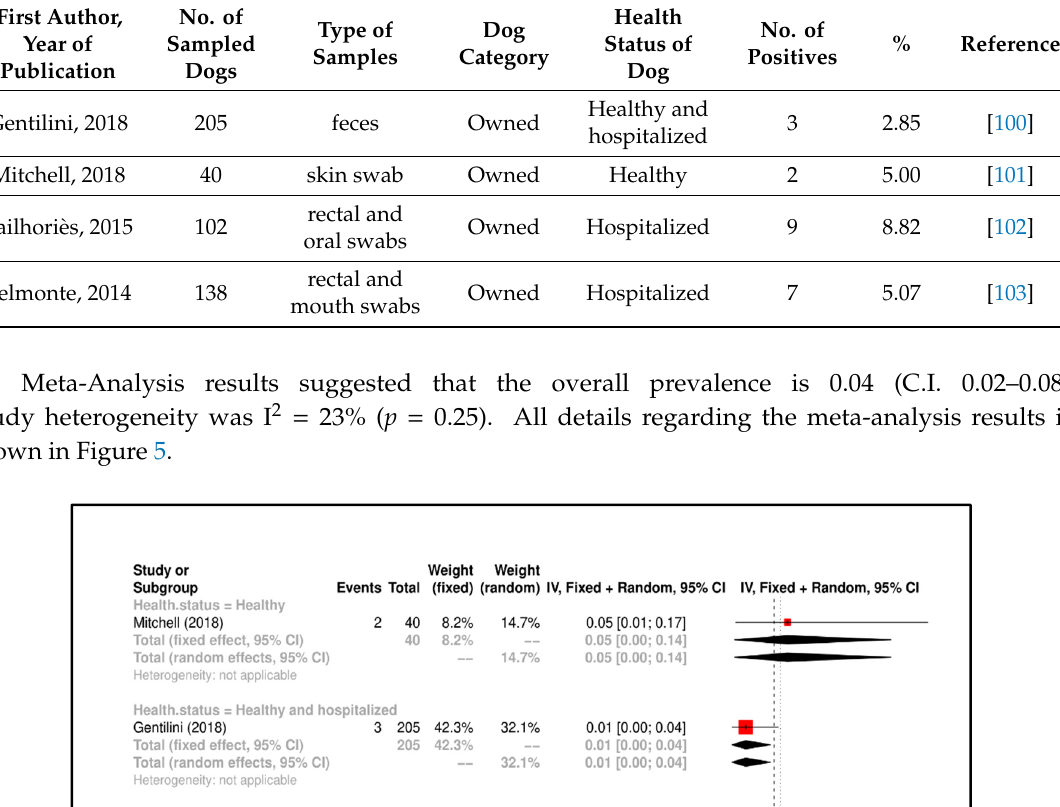
Table 5. Data of the included articles regarding the presence of Acinetobacter baumannii in dogs.